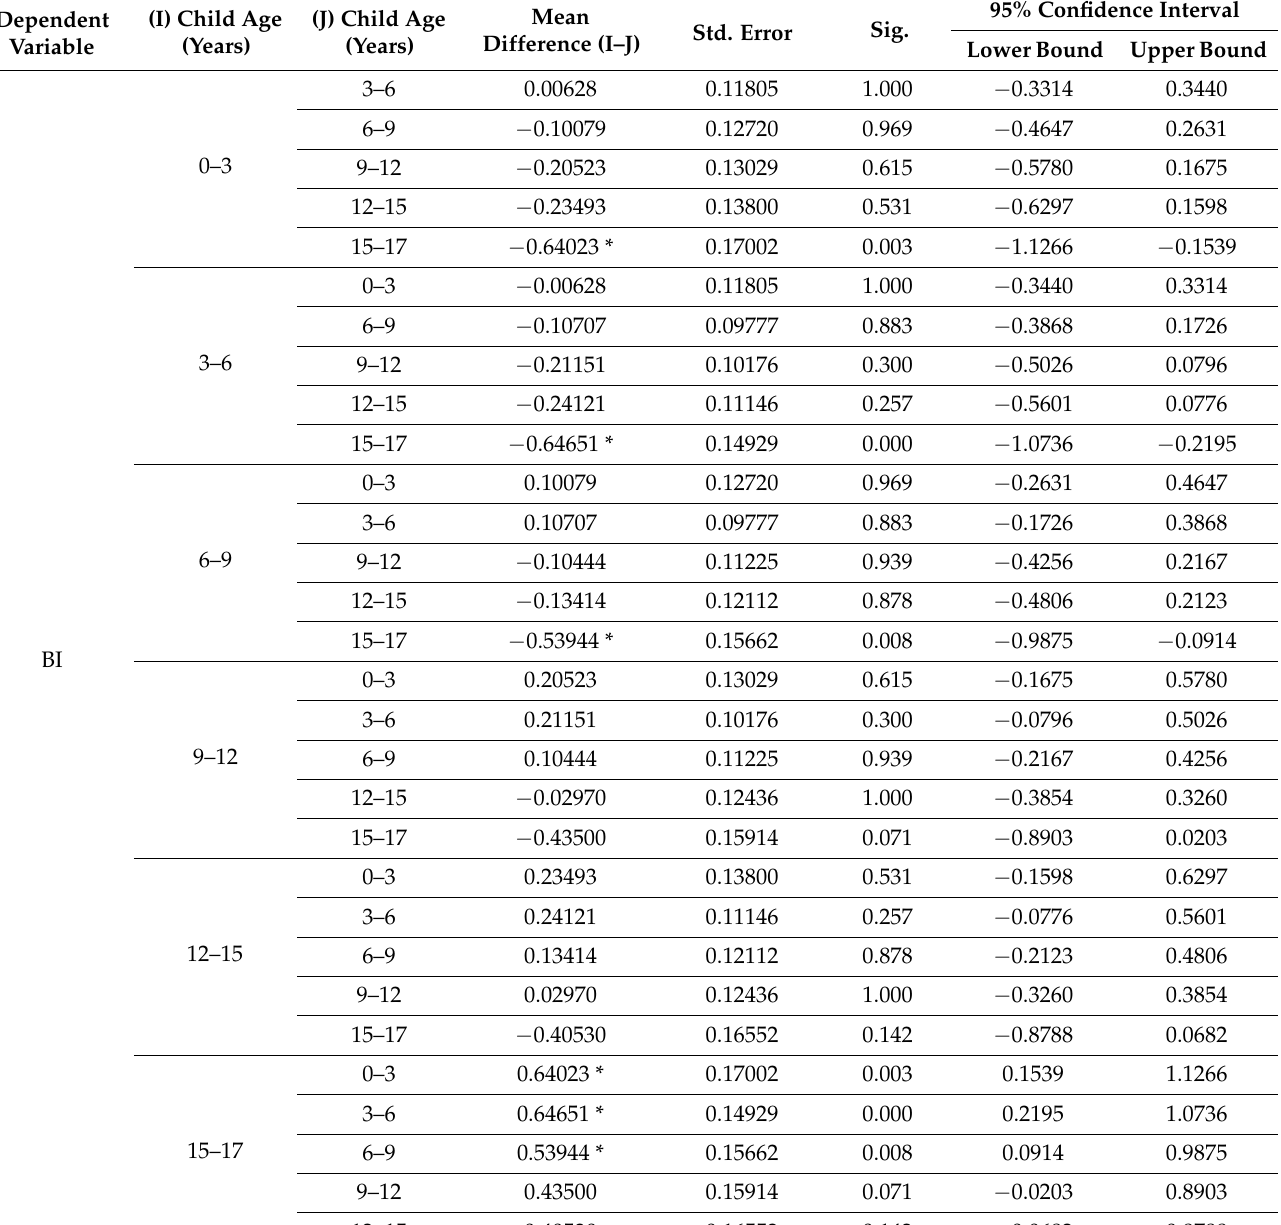
Table 15. Multiple comparisons analysis of the BI attributed to the child’s age using Tukey HSD.